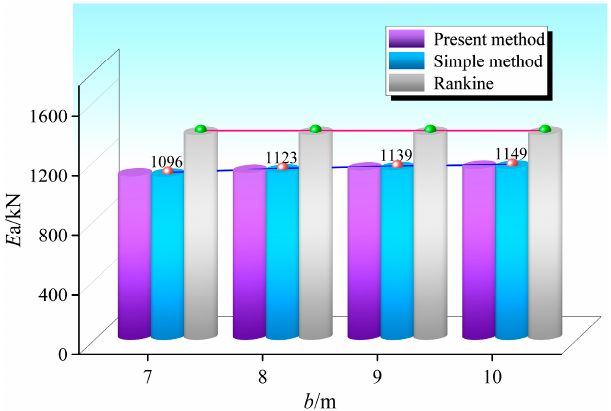
Figure 19. The influence of finite soil width.